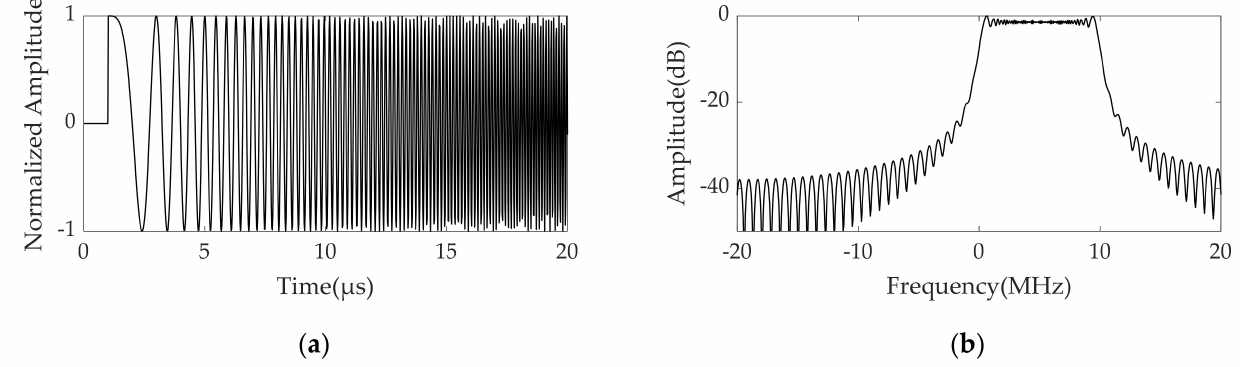
Figure 3. Time domain and frequency domain distribution of the LFM signal. ( a ) Time domain; ( b ) frequency domain.